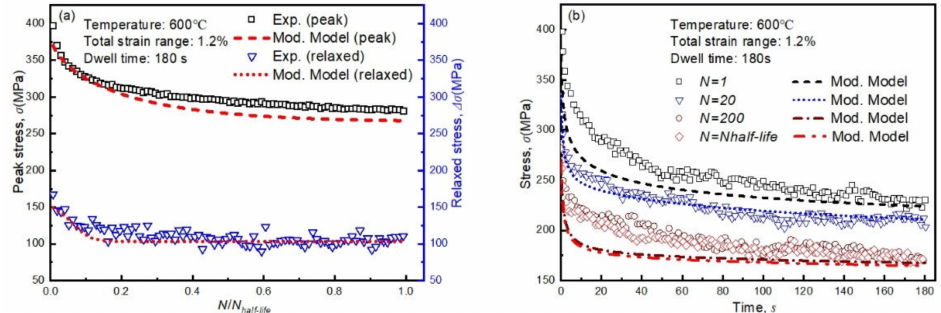
Figure 15. Comparison of simulated and experimental peak and relaxed stresses at 1.2% total strain range with 180 s peak tensile strain dwell at 600 ◦ C: ( a ) evolution of peak stress and relaxed stress, ( b ) stress relaxation during dwell time at various cycles.